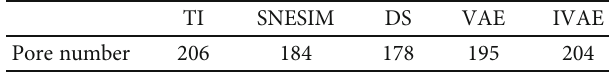
Table 5: The pore number in the TI and the average pore numbers in the reconstructions of IVAE, SNESIM, VAE, and DS.